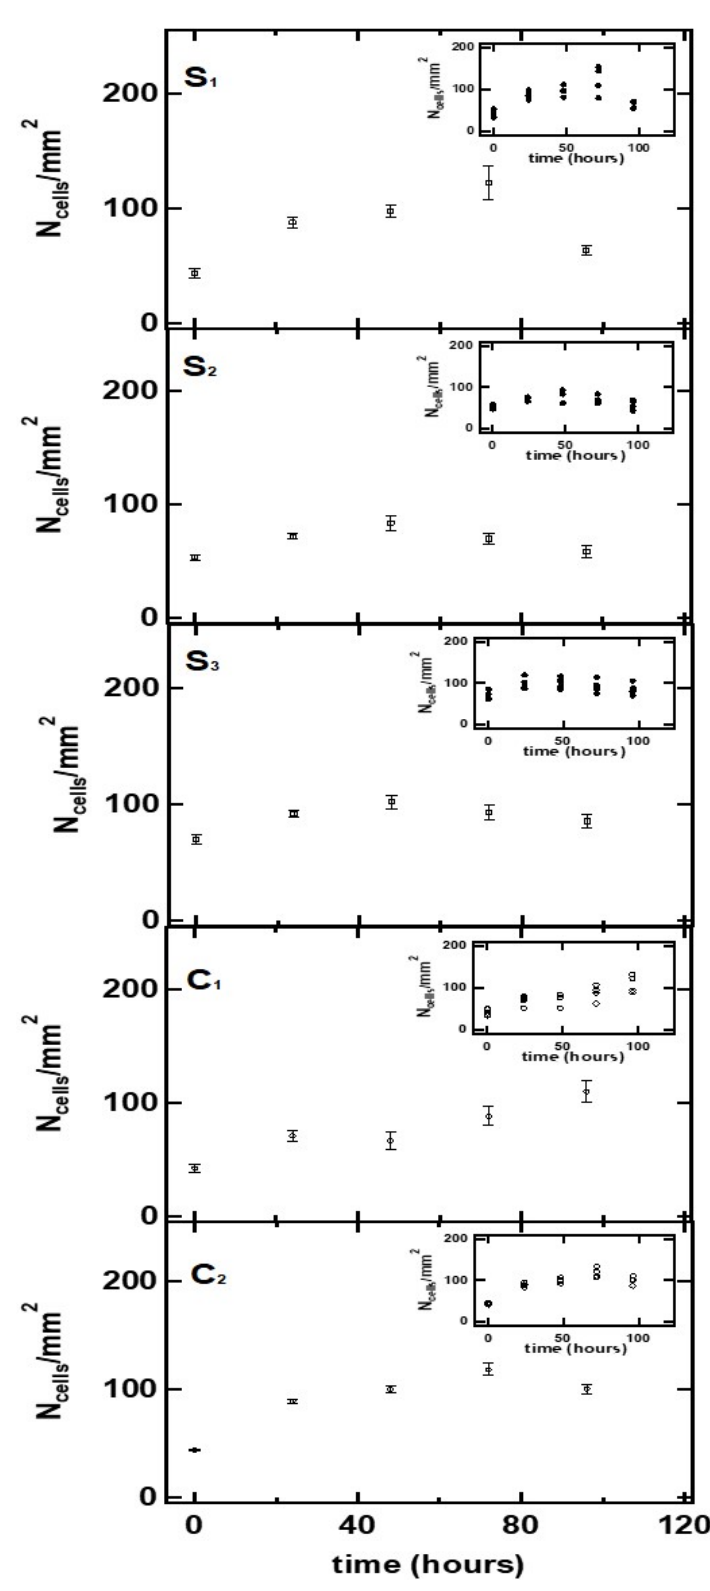
Figure 5. The density of adenocarcinoma cells following a single dose of CaS NS (S 1 , S 2 , S 3 ) and vehicle controls (C 1 and C 2 ). The error bars represent the standard deviation of the measurements. The individual measurements performed are indicated in the insert in the upper right corner of each graph. The amount of Ca 2+ in the NS dispersion corresponds to 4 × 10 − 8 moles.